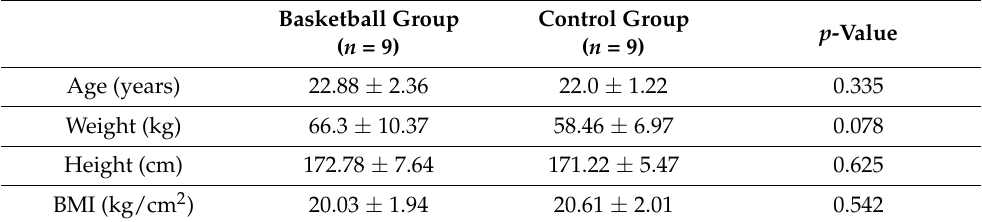
Table 1. Anthropometric characteristics of the study